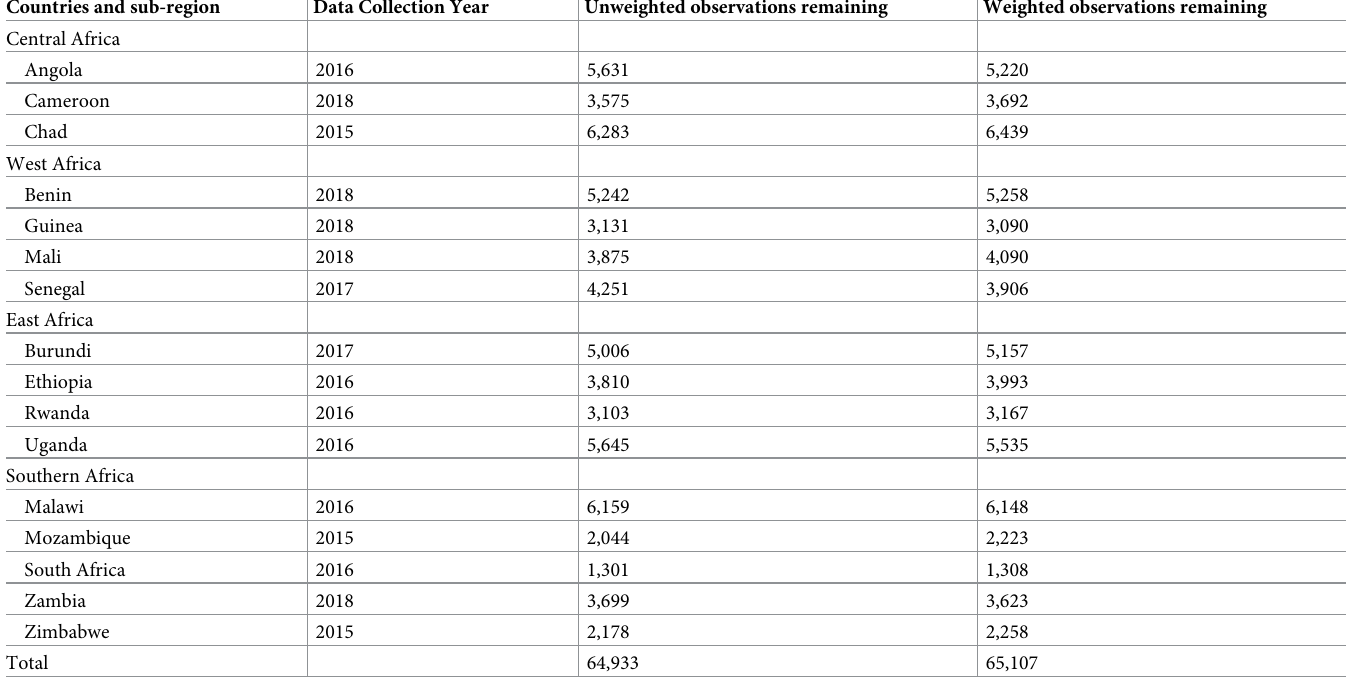
Table 1. Sampling distribution and